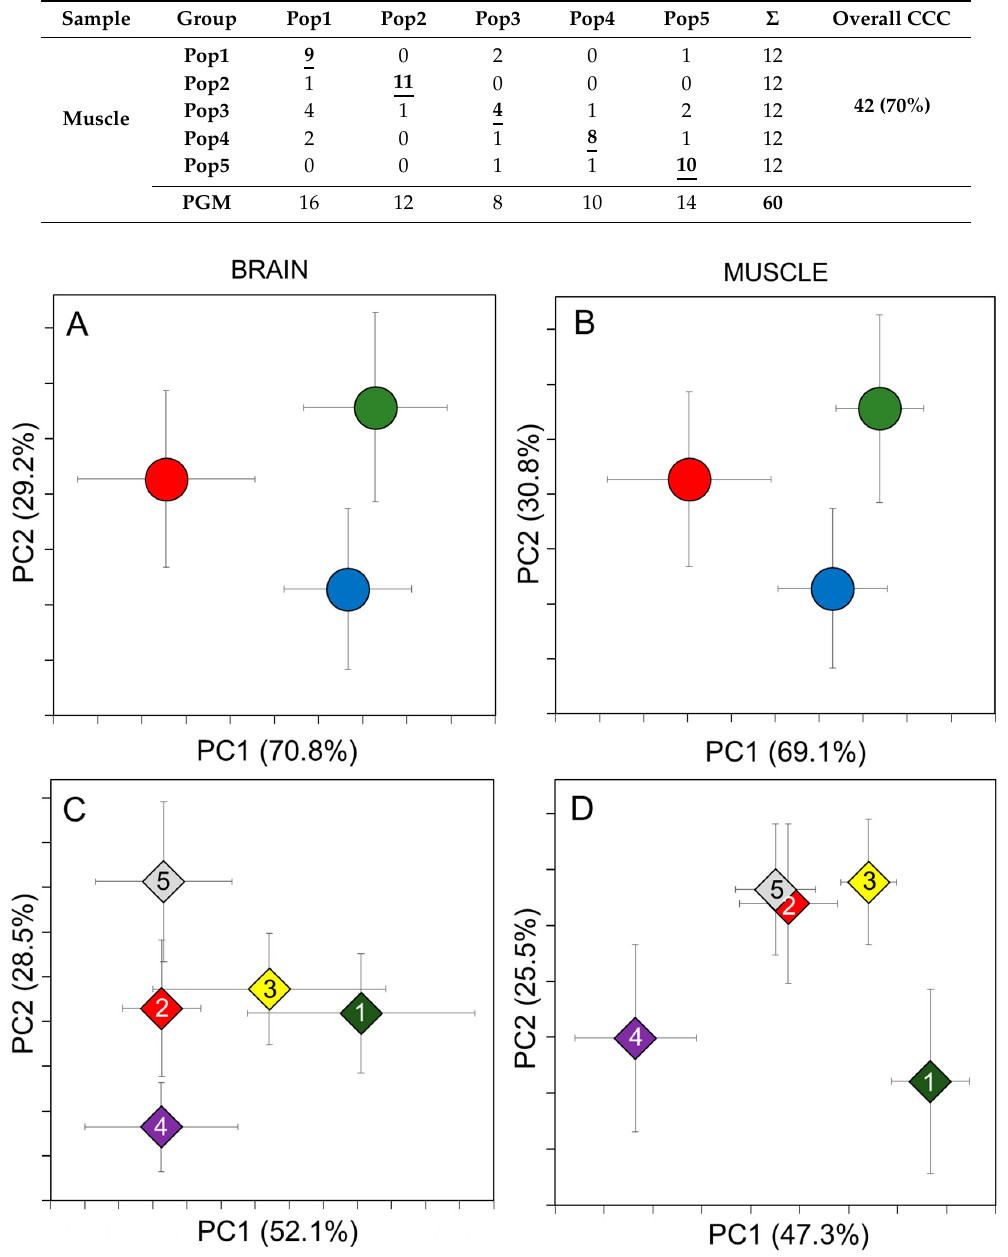
Figure 3. Principal Component Analysis plots of MALDI-TOF MS data derived from brain and muscle samples. Groups were set up by genetic features ( A , B ) and collection site ( C , D ). Red circle: Southern haplogroup, Blue: G. obtusirostris , Green: G. sp1. Numbered icons in the C , D subfigures are identical with the populations sorted on Table 1 and Figure 1. For clarity only the group centroids are shown, with vertical and horizontal whiskers indicating the standard deviation of individual data. The explained variance in each axis is indicated in parenthesis. The original PCA showing all individuals data are available in Figure S2.